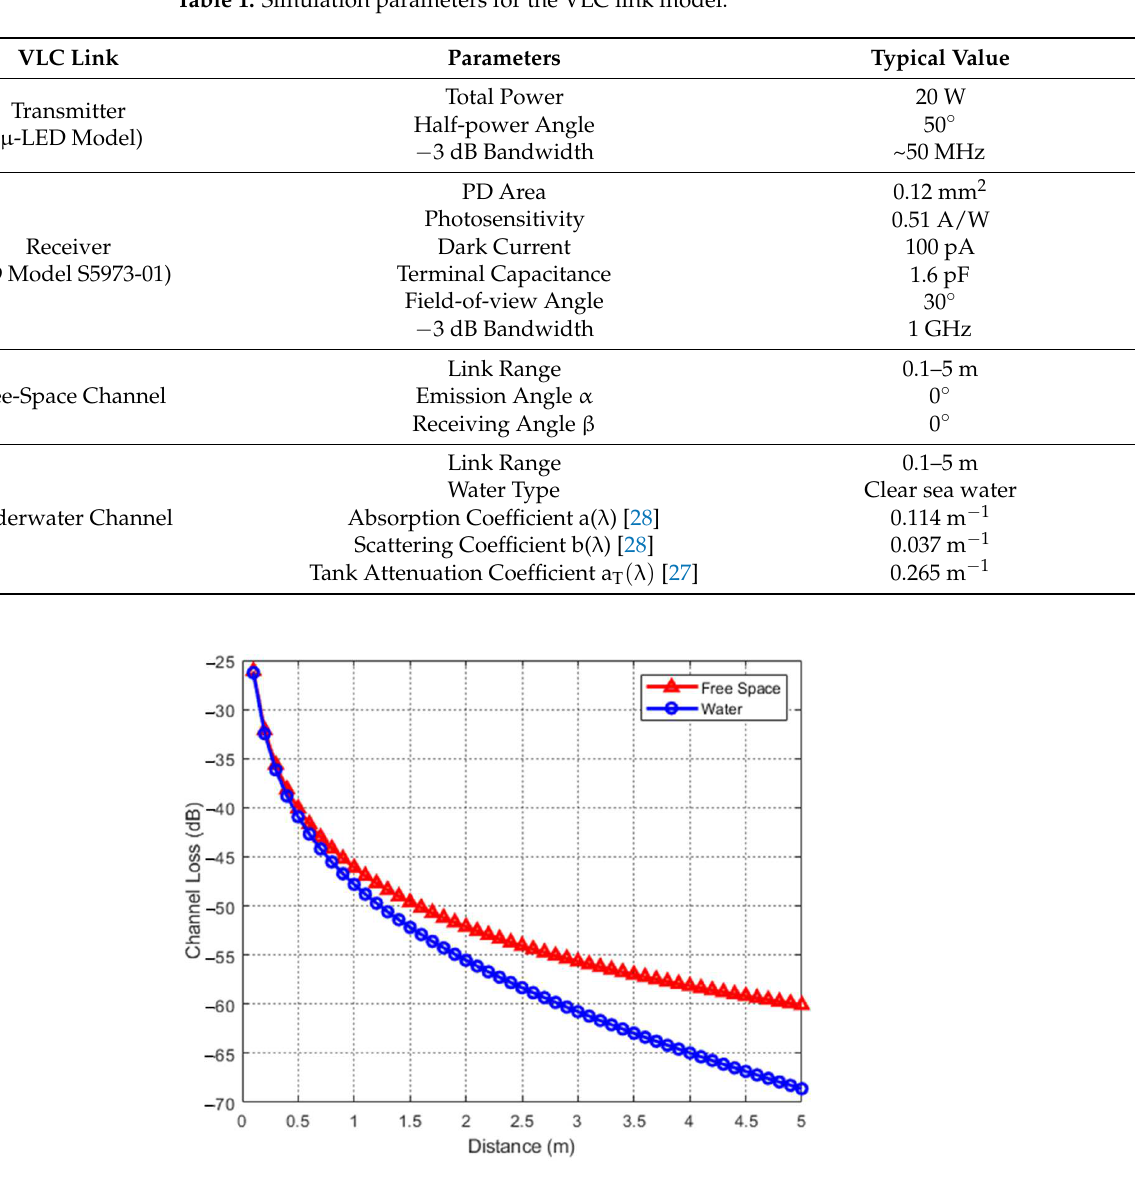
Figure 4. Simulated path loss versus distance in free-space channel and water channel.